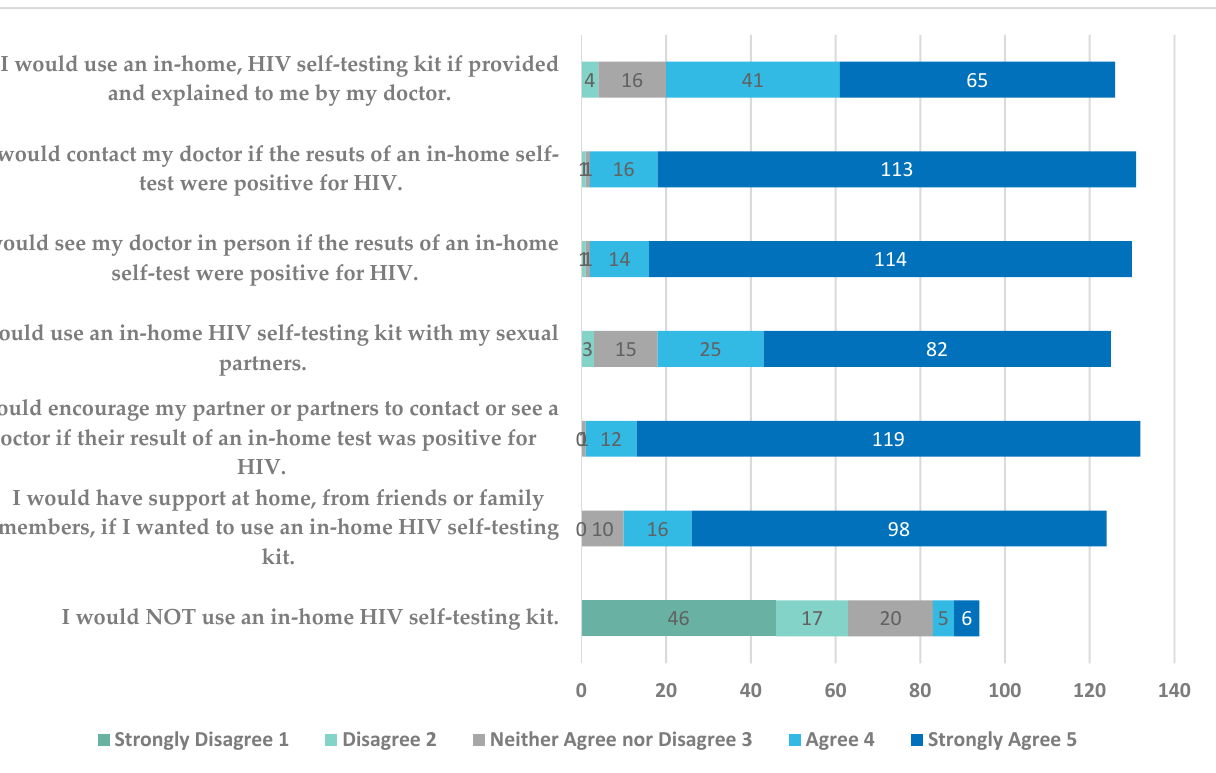
Figure 2. Likert-Scale Responses for HIV Self-Testing at Home Questions. There were no statistically significant differences ( p > 0.05) between the various demographic groups (gender, previous HIV testing, previous STI testing, and ever STI positive) and responses to the Likert-scale questions regarding attitudes about HIV self- testing at home. HIV-positive patients were analyzed separately due to their positive